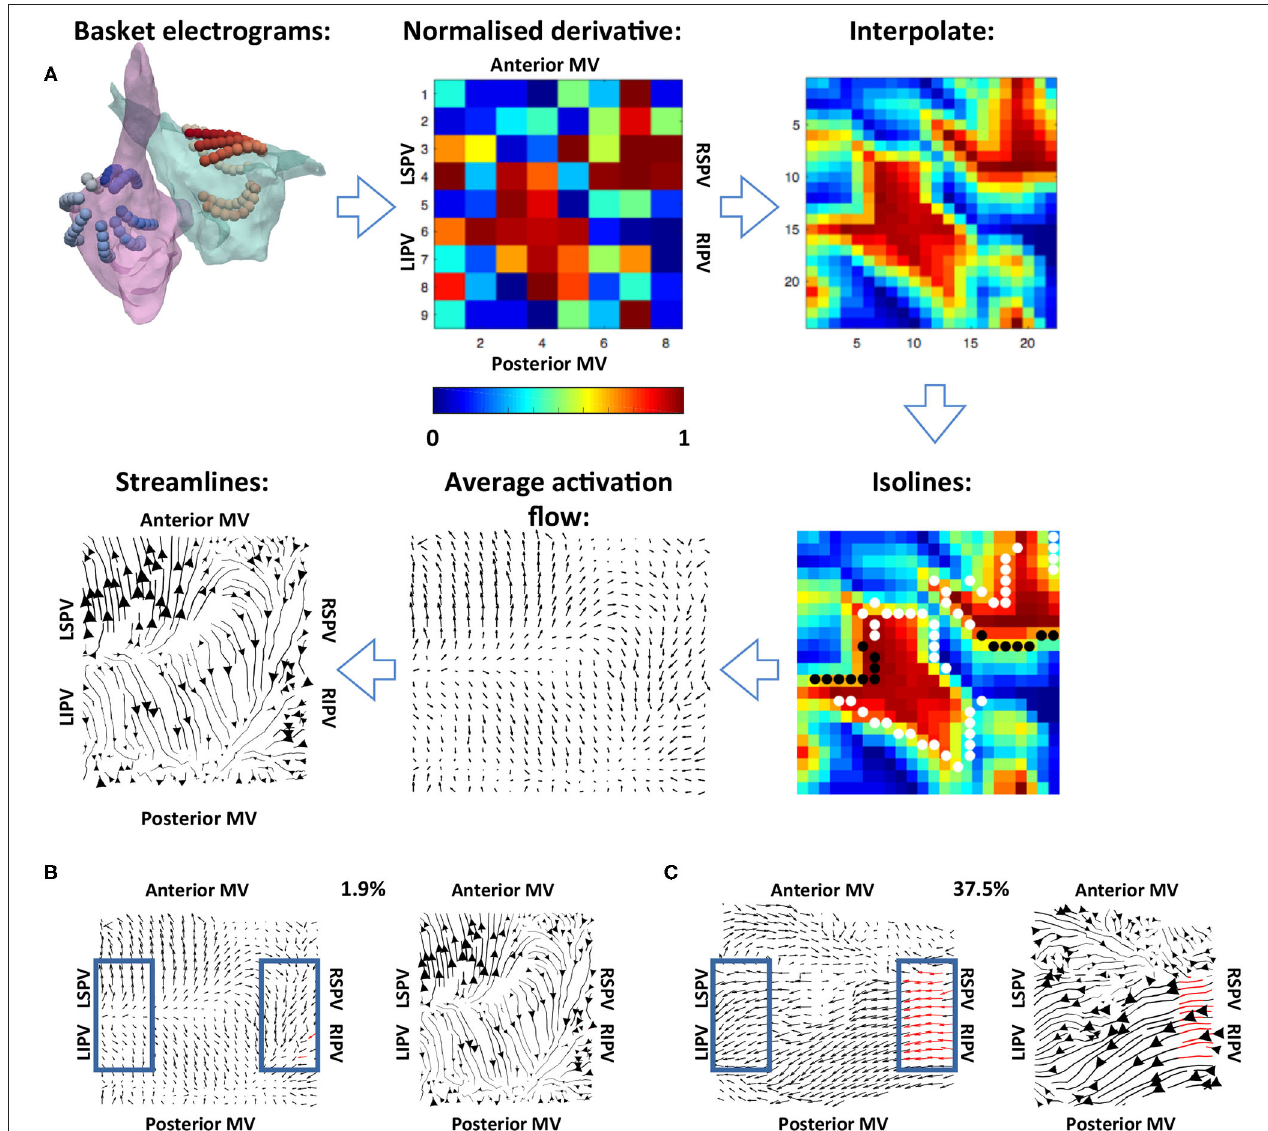
FIGURE 2 | Methodology used for calculating the average activation flow vector field from unipolar electrograms. (A) The normalised filtered derivative signal for each electrode on the basket catheter was displayed in a regular 9 × 8 grid. These signals were interpolated to a higher resolution grid, and optical flow vectors were calculated. The vectors were averaged over time for isolines of constant normalised filtered derivative signal (indicated by white and black dots; wavefront and wave back). Finally, streamlines were calculated from average optical flow vectors to visualise activation pathways. The normalised derivative, interpolate and isoline plots are snapshots representing the wavefronts at a given time in the recording, while the average activation flow and streamlines are calculated as an average across the 10s recording. (B) Example PV activation flow calculation for a case with low PV activation flow. Vectors within the blue boxes were assessed, with red vectors tagged as PV antra to LA activation flow. (C) Example PV activation flow calculation for a case with high PV activation flow. at that point. An example is shown in the final subplot of Figure 2 . To quantify the degree of PV antra to LA body activation flow, the percentage of optical flow vectors that were of threshold magnitude and directed into the LA were calculated. This analysis was performed for vectors within a box close to the left PV and a box close to the right PV, indicated in blue in Figures 2B,C . Specifically, vectors within these boxes were tagged as PV to LA activation flow in the case that their magnitude was larger